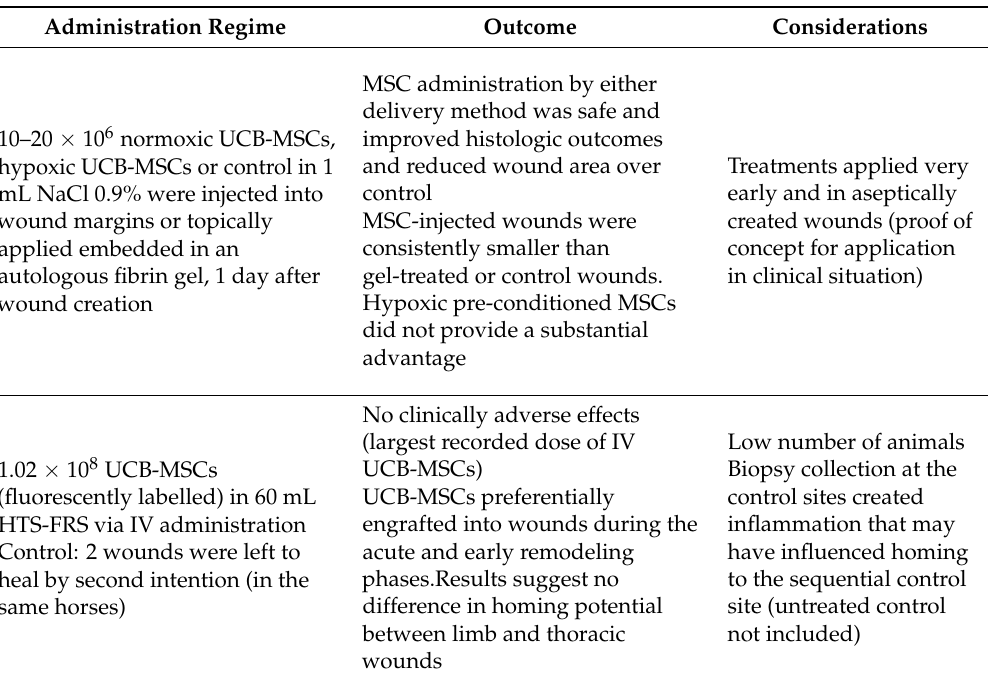
Table 3. In vivo studies using mesenchymal stem cells for integumentary system disorders. Umbilical cord-derived stem cells (UCB-MSCs), transforming growth factor beta (TGF- β ), cyclooxygenase-2 (COX-2), intravenous (IV), HypoThermosol FRS (HTS-FRS), peripheral blood stem cells (PB-SCs), phosphate-buffered saline (PBS), amniotic fluid MSCs